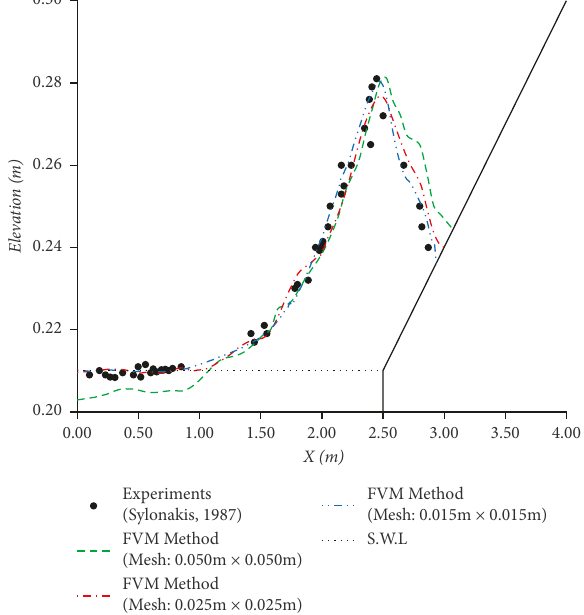
Figure 8: The simulation results of the solitary wave on the sloped (1 :19.75) seawall at 2.7s.